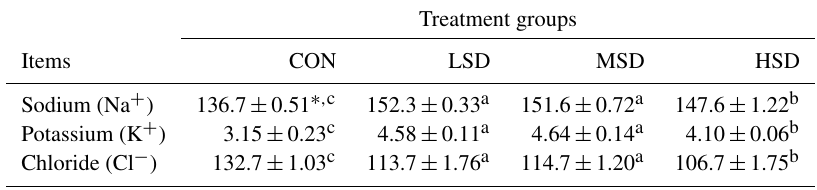
Table 3. Effect of different stocking densities on blood electrolytes (mmolL − 1 ) in meat ducks exposed to heat stress.